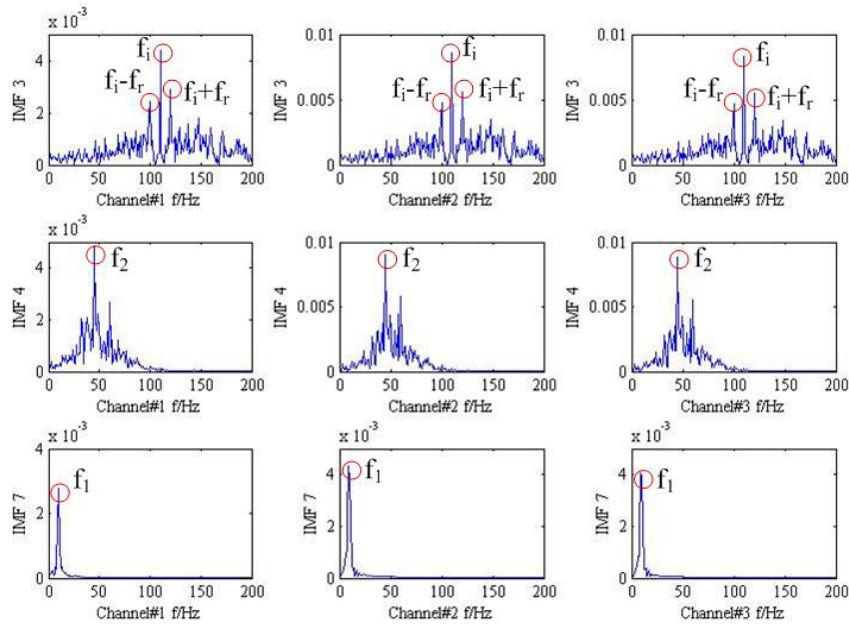
Figure 5. 3th, 4th, and 7th IMFs of different signal in the frequency domain.